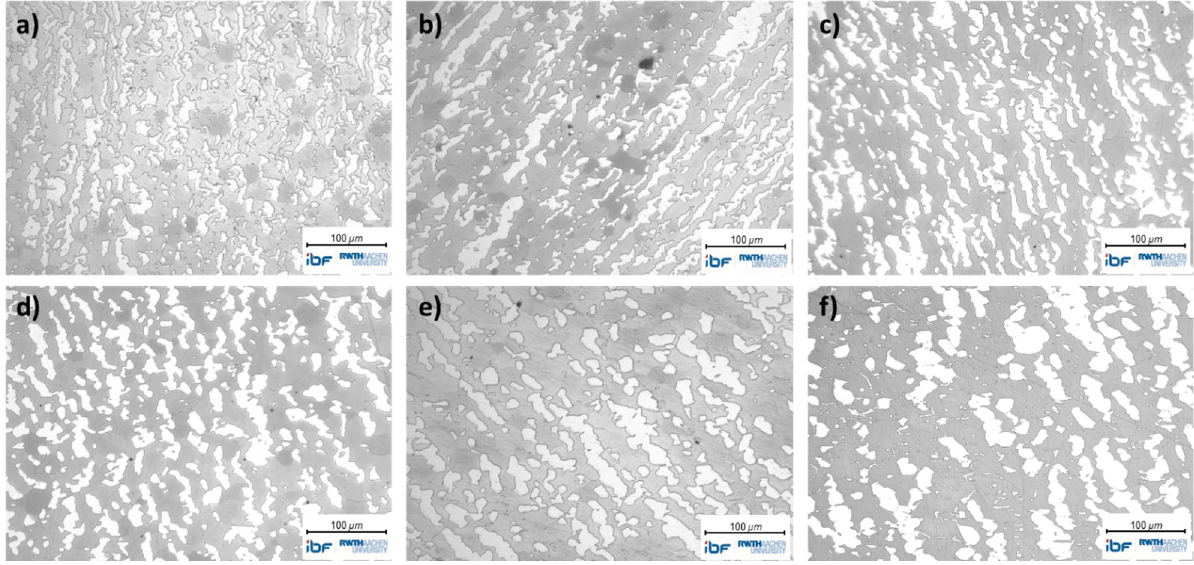
Figure 5. Microstructures after compression tests at 1100 °C and 0.1 s − 1 with an initial ferrite volume fraction of ( a ) 57%, ( b ) 58%, ( c ) 60%, ( d ) 62%, ( e ) 71% and ( f ) 75%. Ferrite is depicted as grey and austenite as white.